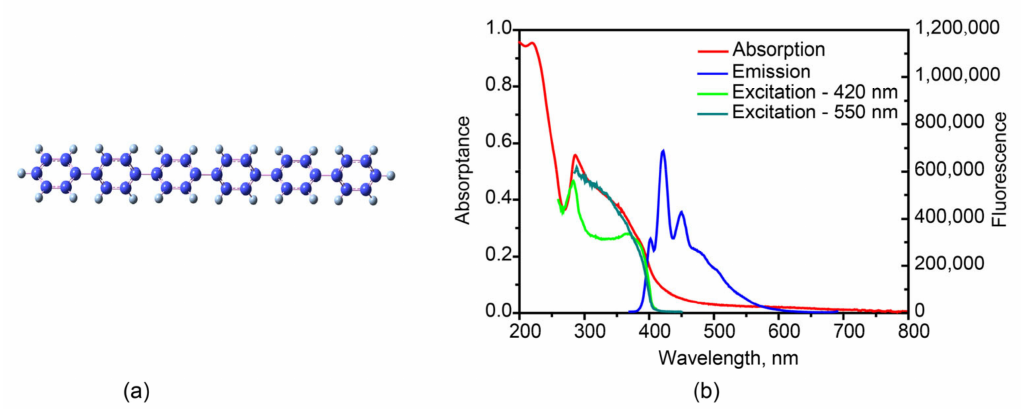
Figure 1. ( a ) Structure of hexaphenyl. ( b ) Steady-state absorption, fluorescence and excitation spectra of hexaphenyl film ( λ exc = 350 nm, λ em = 420 and 550